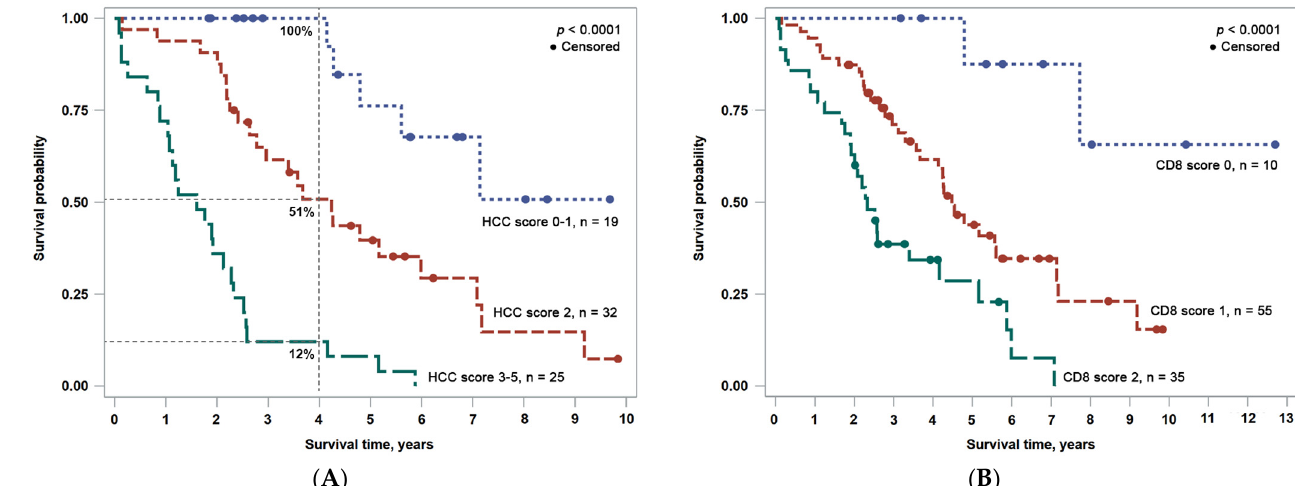
Figure 4. OS risk stratification based on combined prognostic scores: ( A ) comprehensive HCC OS score derived from five independent predictors from Model 5; ( B ) combined CD8 OS score derived from two independent predictors (CD8 density profiles at malignant and non-malignant interfaces).